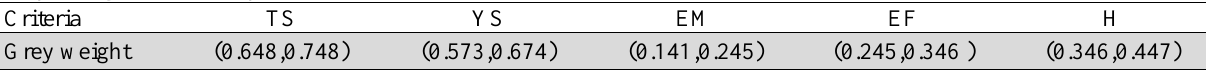
Grey weights for alloy steels Criteria TS